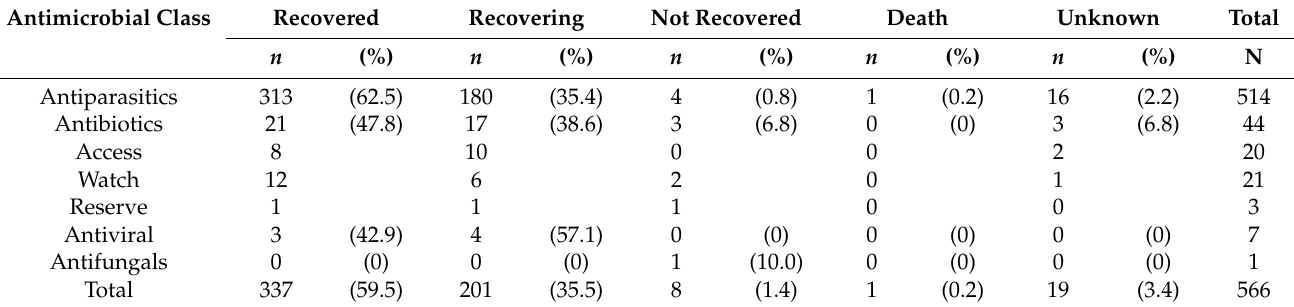
Table 4. Patient outcomes stratified by antimicrobial drug classes in ICSRs in the VigiFlow between 2017–2021 in Sierra